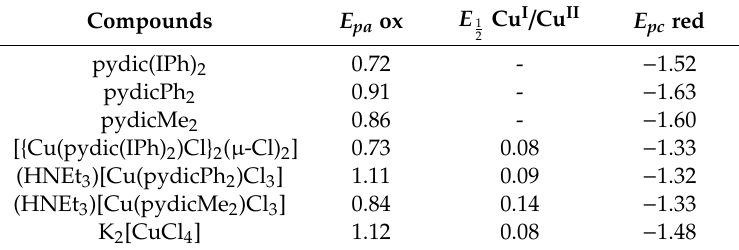
Table 5. Selected electrochemical data a